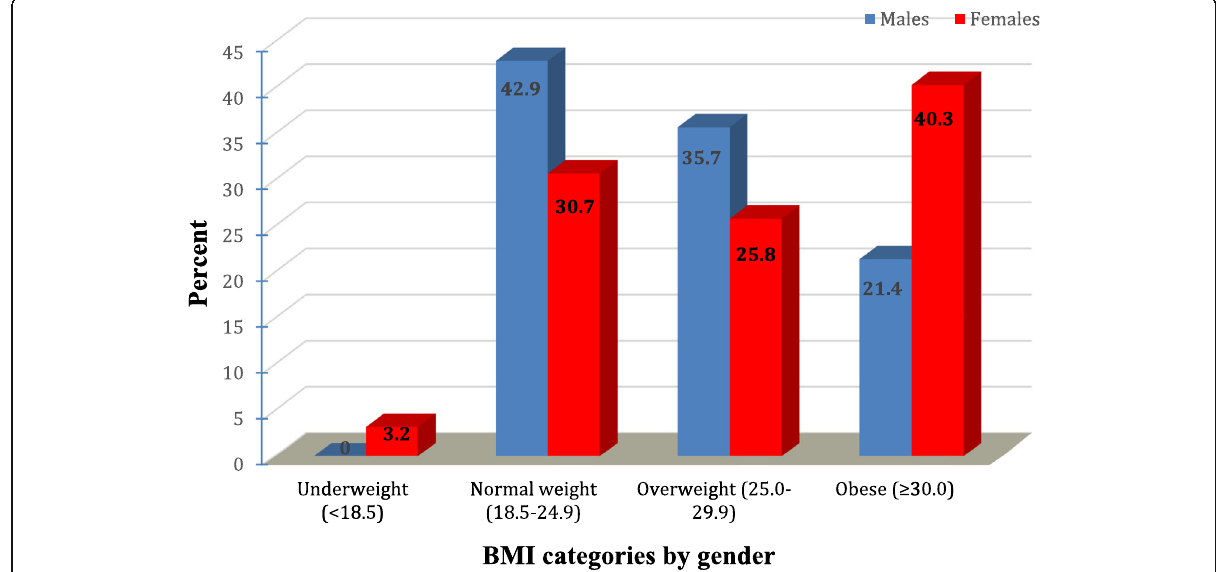
Fig. 1 Percent distribution of the studied multiple sclerosis patients at Kasr Al-Ainy Hospital according to BMI categories and gender (n =